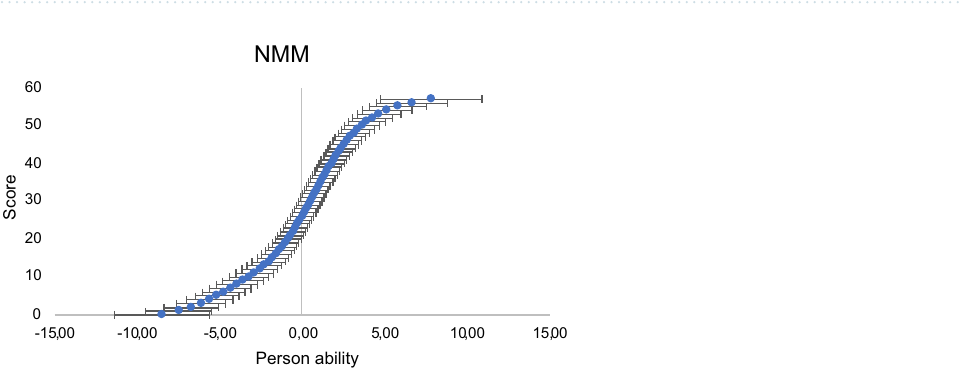
Table 3. Conversion table from NMM (57 items) to each legacy test for both raw scores and measures (in logits) and converted into a 0–100 scale. 2SE corresponds to measurement uncertainties with a coverage factor of 2.